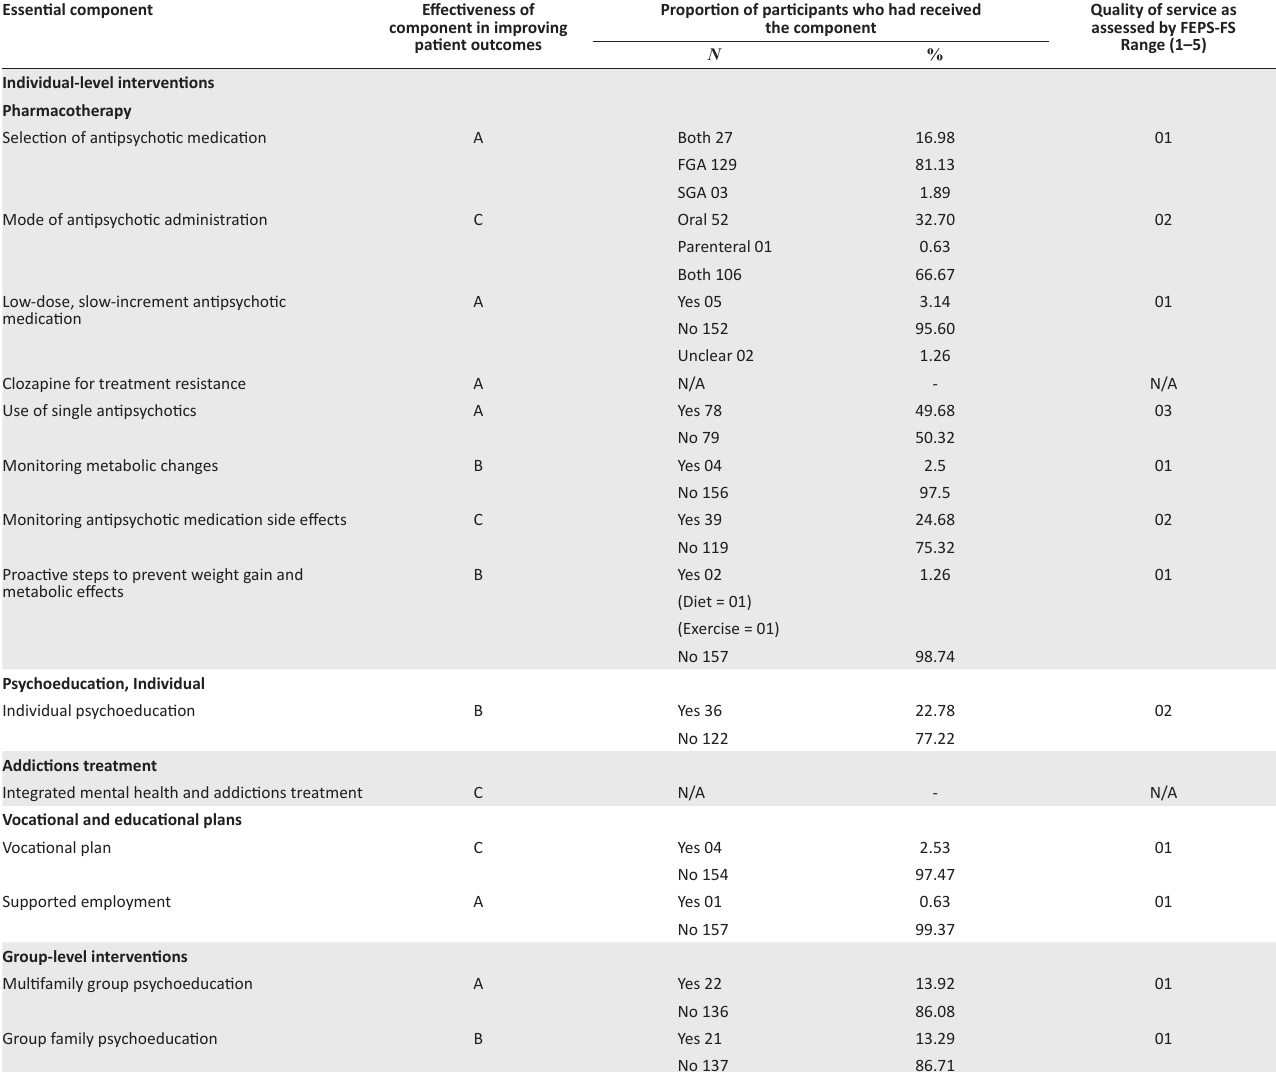
TABLE 4: Quality of essential components for individual and group level interventions. Essential